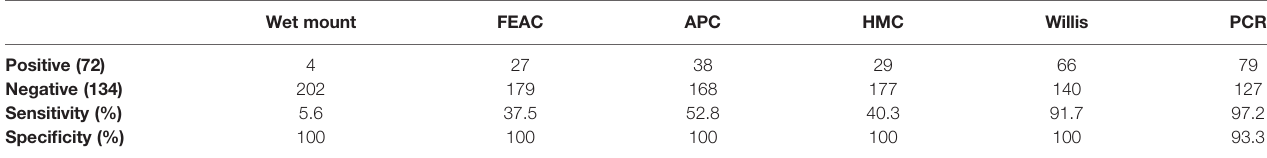
TABLE 1 | Comparison of the parasitological and molecular methods in the detection of Trichostrongylus spp. in fecal samples ( n = 206). Wet mount FEAC APC